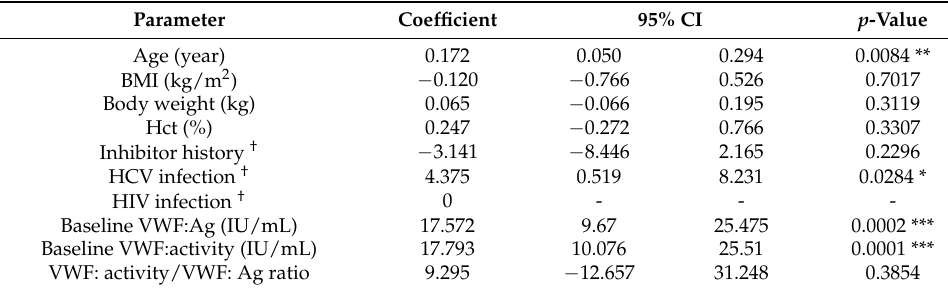
Table 4. UVLR analysis of the half lives of the O group patients, n = 20.